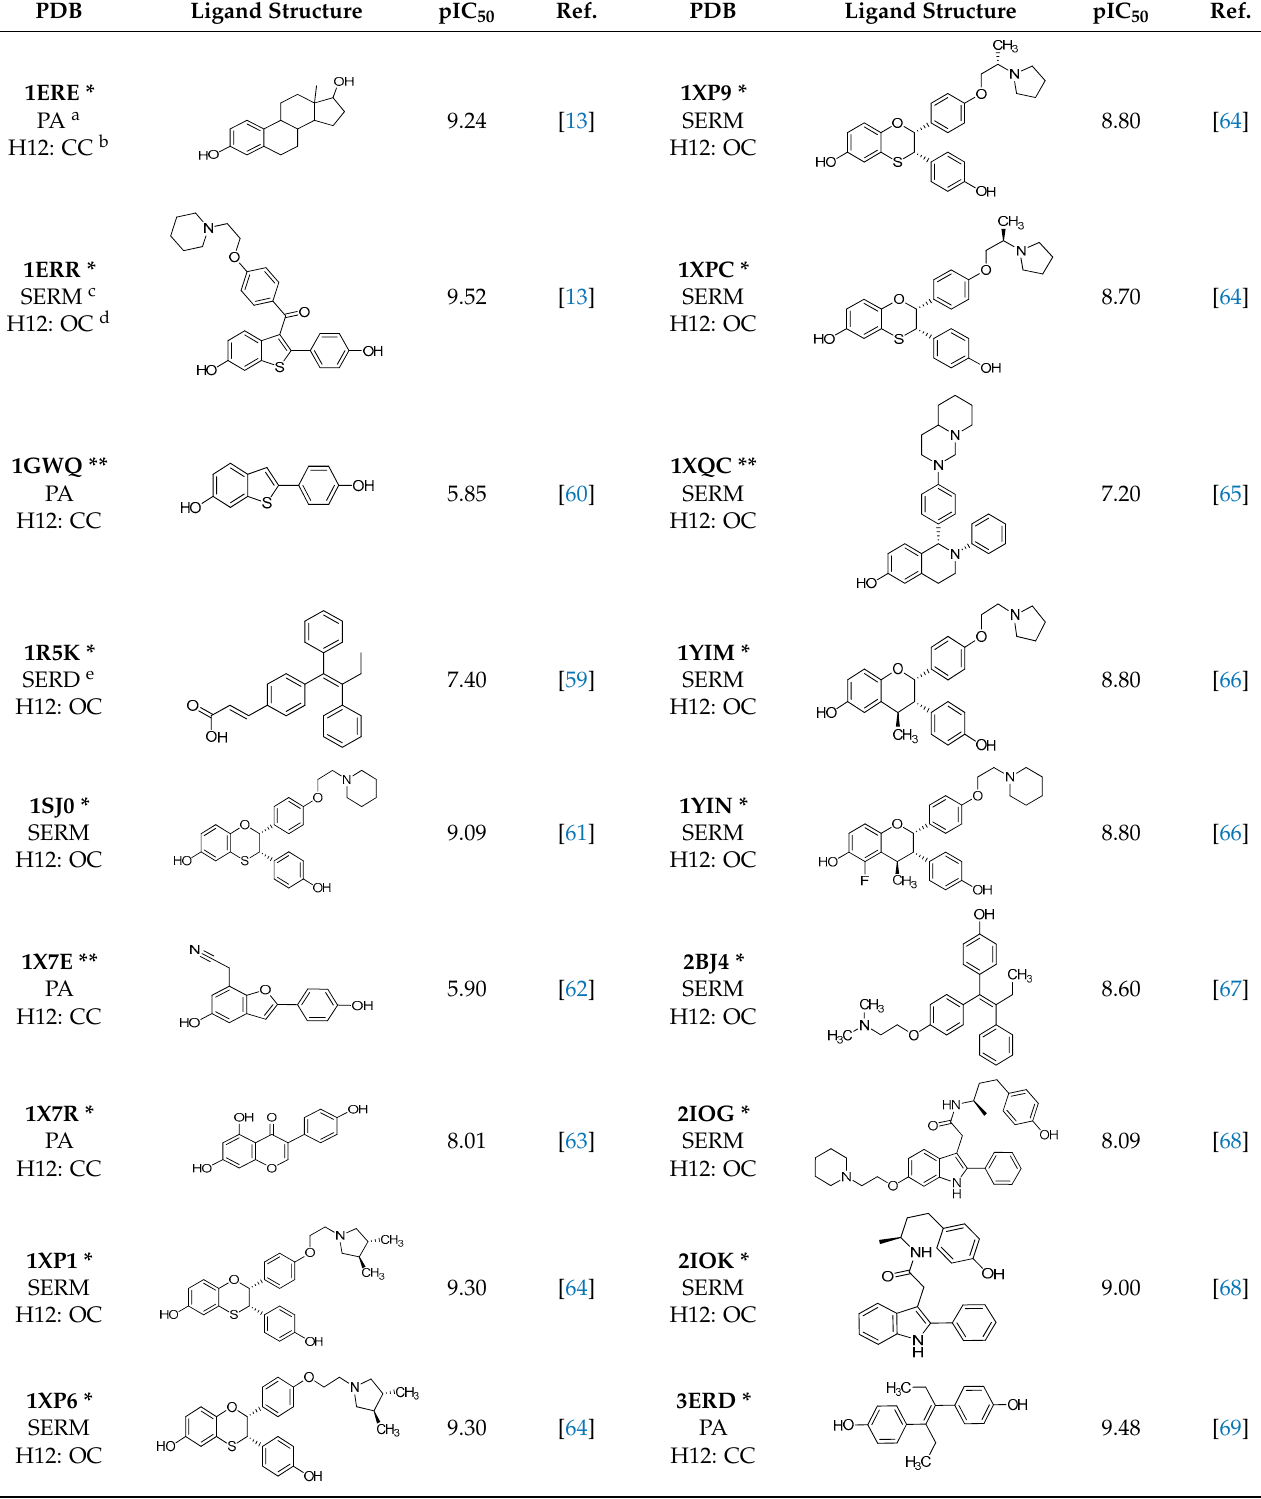
Table 1. PDB codes, ligand structures, and pharmacological profile of wild-type (WT) estrogen receptor α complexed with antagonists and partial agonists, for the 3-D Pharmacophore hypotheses generation compounds were classified into “actives” (PDB codes marked with a star) and “inactives” (PDB codes marked with a double star) using a threshold pIC 50 value of 7.30.